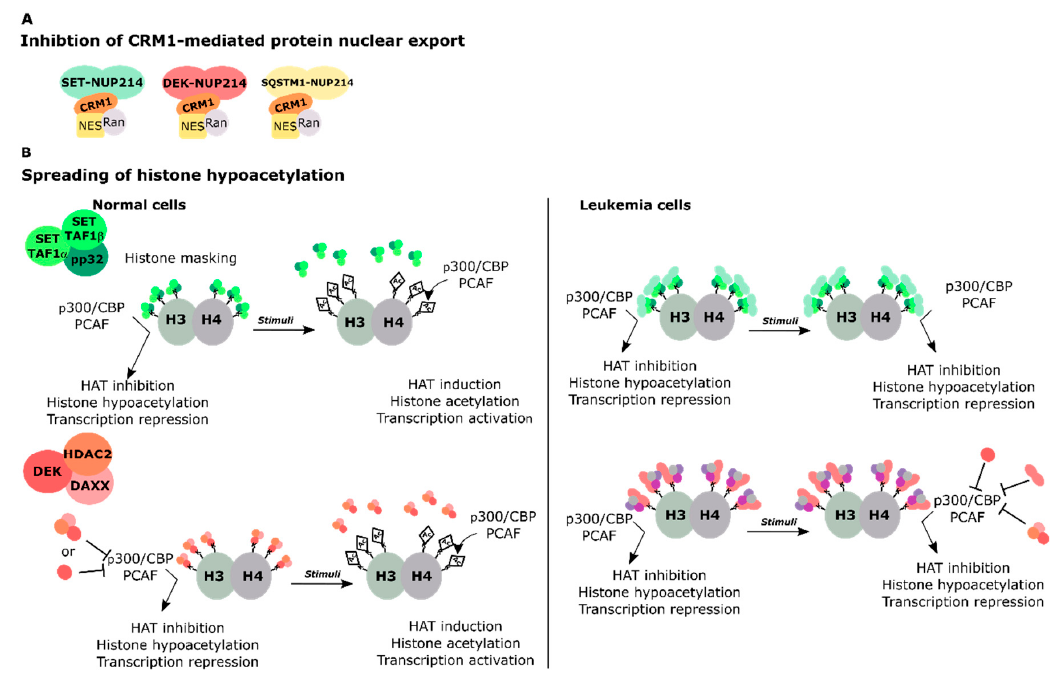
Figure 3. Putative models of gene regulation by SET-NUP214, DEK-NUP214, and SQSTM1-NUP214 fusion proteins. ( A ) Inhibition of CRM1-mediated nuclear export by sequestering nuclear export complexes into nuclear bodies formed by the fusion proteins. This may lead to nuclear accumulation of transcription factors that activate of HOX gene expression; ( B ) Spreading of histone hypoacetylation and transcriptional repression of genes involved in HOX activation. SET and DEK inhibit the transcriptional activity of the HATs p300/CBP and PCAF. Upon transcriptional stimuli, the interaction of SET and DEK with histone lysines is disrupted and HATs can co-activate transcription. In leukemia, SET-NUP214 preserves the dimerization domain of SET. SET-NUP214 may enhance the binding of endogenous SET to histones, in a mechanism similar to histone masking. DEK-NUP214 retains most of the histone binding domains of DEK and thus it may preserve histone binding capacity. In this model, DEK-NUP214 recruits additional, yet unknown, factors to chromatin. The NUP214 FG portion of the fusion proteins may contribute to aberrant histone hypoacetylation activity of SET and DEK due to their altered intracellular localization, which would result in the transcriptional repression of otherwise active